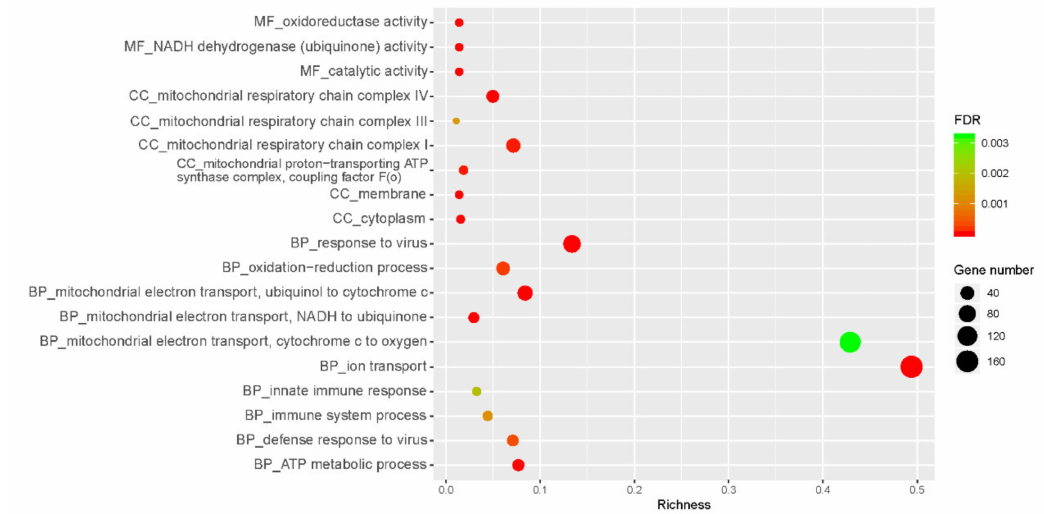
Figure 3. Function annotation-GO analysis of DEGs. FDR: false discovery rate; MF: molecular functions; BP: biological process; CC: cellular component. The x-axis is the richness calculated from the numbers of DEGs in a term divided by all the genes included in that term. As shown on the right side of the figure, the size of the circumference correlates with the number of